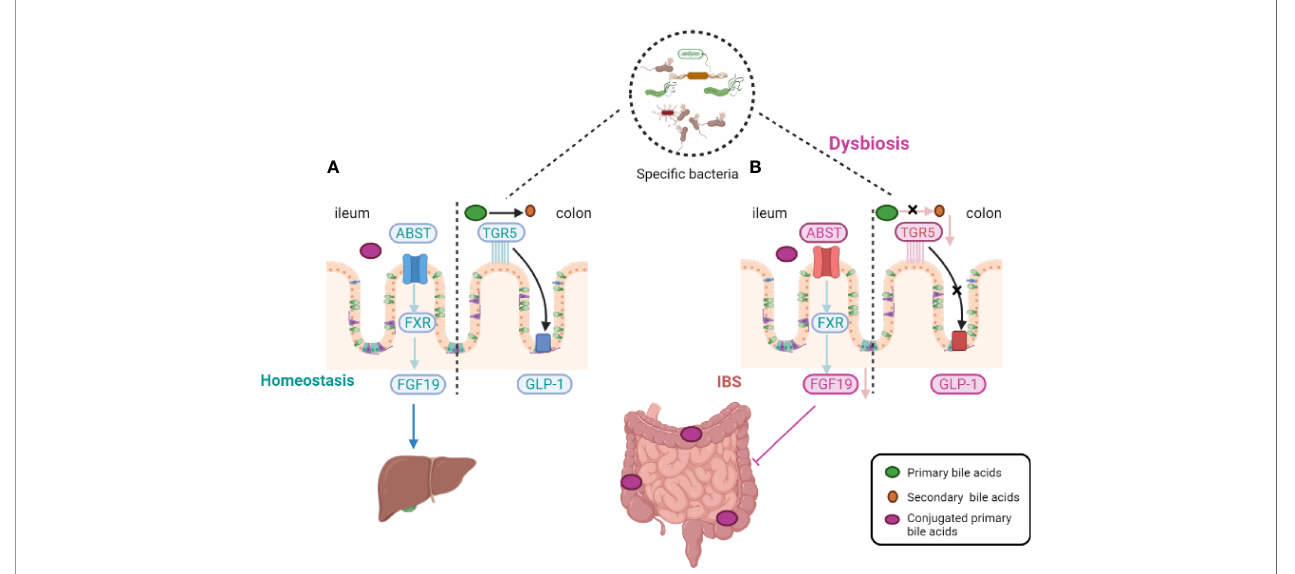
FIGURE 1 | Host-microbiota interactions during bile-acid metabolism. In homeostasis, primary bile acids are converted into secondary bile acids with the assistance of intestinal fl ora and Takeda-G-protein-receptor-5 (TGR5) (see the fi gure, part A ). Gut microbiota alterations induce an impairment in the ileal absorption of BAs, which occurs normally via the apical-sodium BA transporter (ASBT). This induces a decrease in the expression of nuclear Farnesoid-X receptor (FXR) and fi broblast growth factor 19 (FGF19) in intestinal epithelial cells and the abundance of colonic primary conjugated BAs. Gut microbiota dysfunction leads to a decreased transformation of primary conjugated BAs to secondary BAs in the colon, leading to defective activation of (TGR5). TGR5 of glucagon-like peptide 1 (GLP-1) activation effect was thus inhibited (see the fi gure, part B